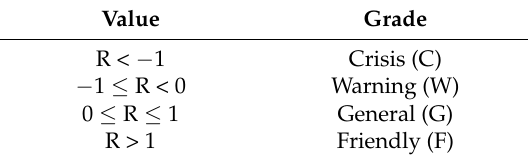
Table 6. The criteria for the identification of